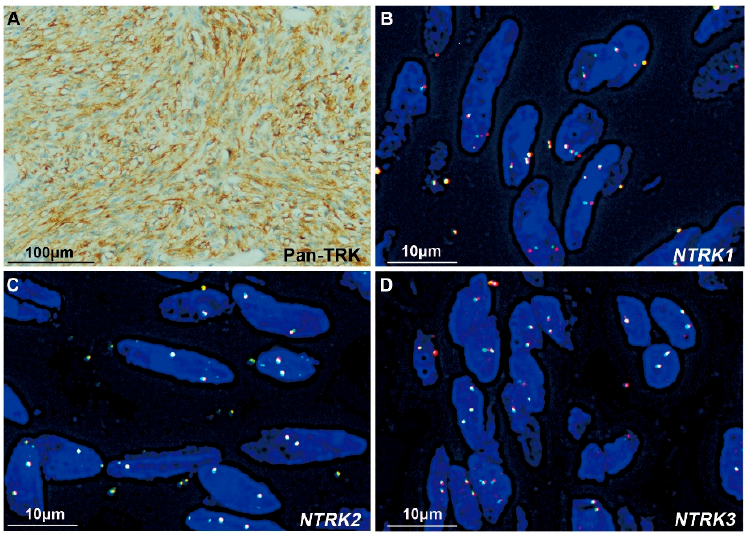
Figure 5. The tumor (case #4) with strong Pan-TRK expression but without NTRK1 , NTRK2 or NTRK3 rearrangement. ( A ) IHC staining showed strong cytoplasmic expression of Pan-TRK (400 × ). Scale bar is 100µm. ( B – D ) FISH images obtained using NTRK1 , NTRK2 , and NTRK3 break-apart probes. The tumor was negative for NTRK1 , NTRK2 and NTRK3 rearrangements. Each scale bar is 10µm.